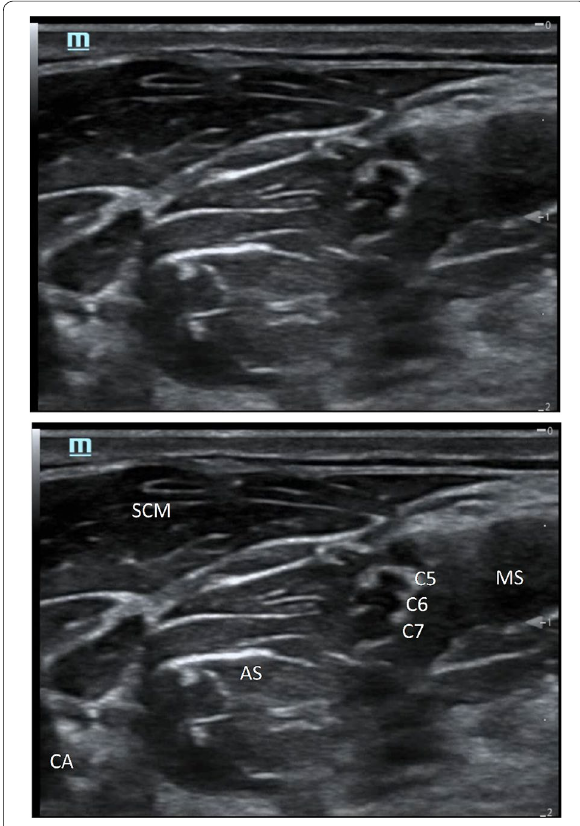
Fig. 2 Image acquisition. To pass this assessment, residents needed to acquire an ultrasound image on a healthy volunteer and identify the sternocleidomastoid (SCM), anterior scalene (AS), middle scalene (MS), interscalene groove (C5–7), and carotid artery (CA). They also had to indicate the needle path and site of injection